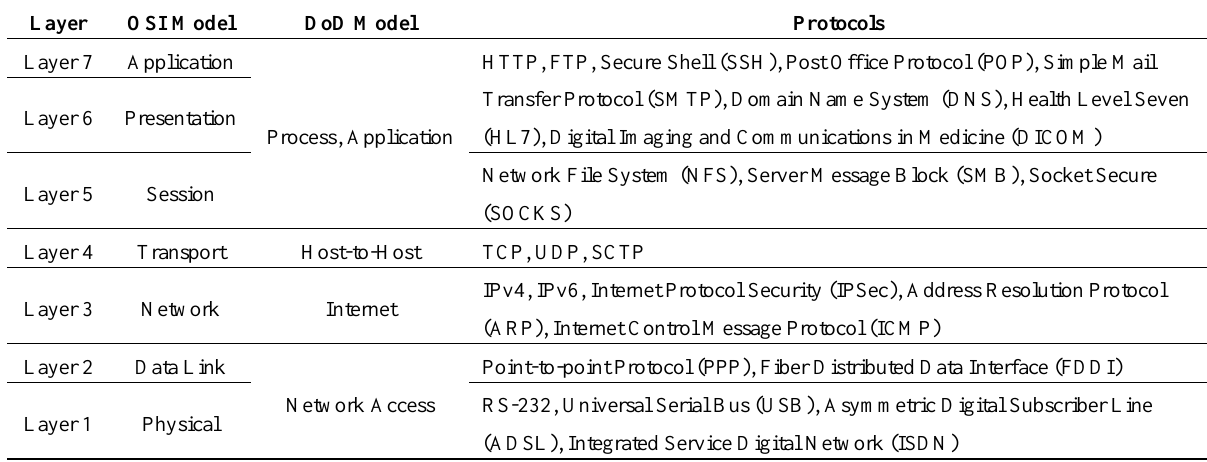
Table 1. Relationship among SCTP and other